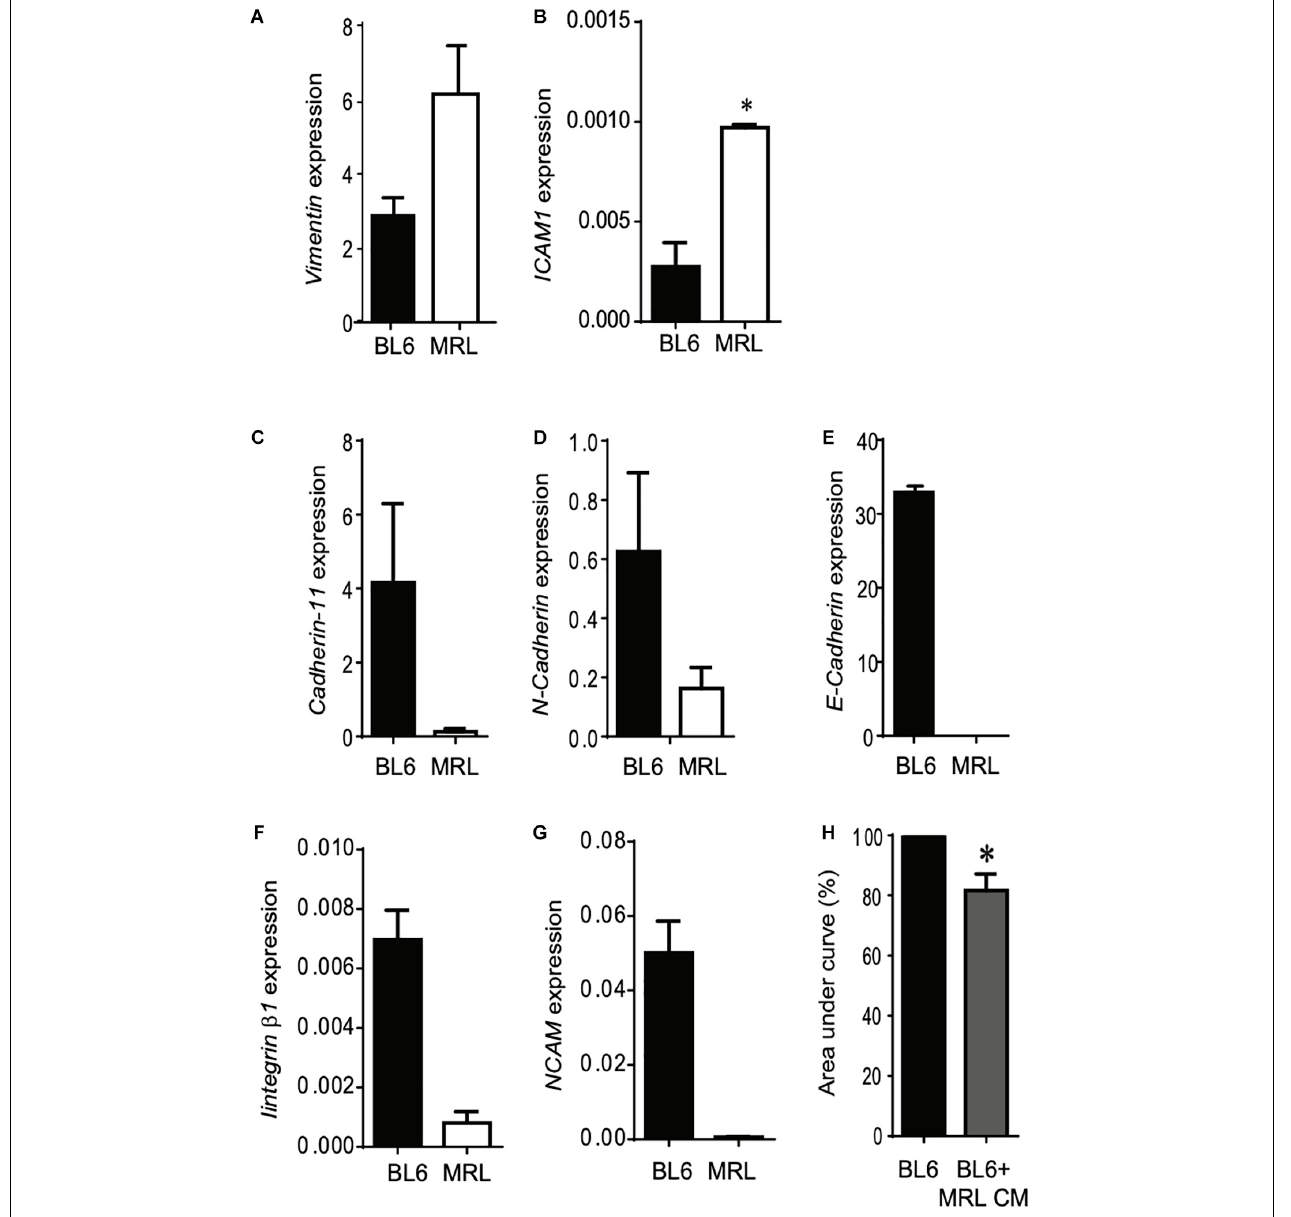
FIGURE 3 | The higher migration potential of MRL MSC is mediated through the release of soluble factors. (A–G) RT-qPCR analysis of Vimentin, ICAM1, Cadherin-11, N-Cadherin, E-Cadherin, Integrin β 1, and NCAM expression levels in MRL MSC and BL6 MSC. Results represented as mean ± SEM ( n = 4 replicates). * p ≤ 0.05. (H) The scratch wound was performed on BL6 MSC monolayer cultured alone or with a conditioned-medium obtained from a 24 h culture of subconfluent MRL MSC (MRL CM). The area under curve (AUC) was calculated from the curve of open wound area percentage over the healing period (0–24 h). *p ≤ 0.05.